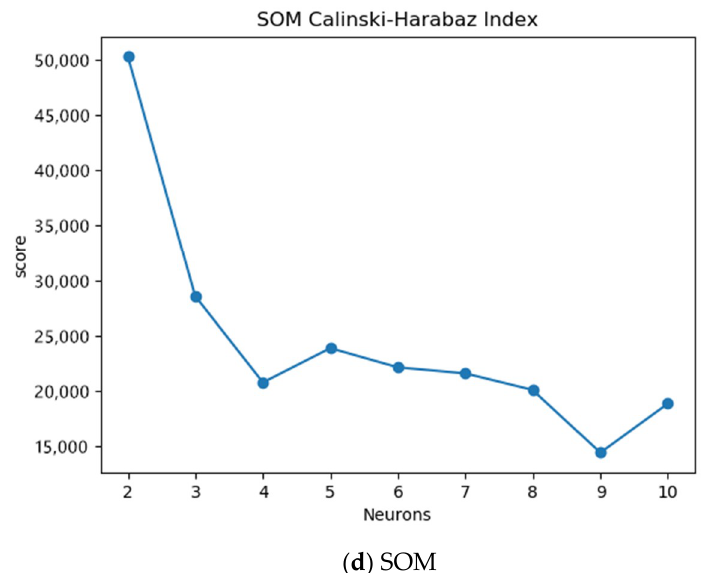
Figure 5. Clustering quality of four algorithms using different parameters.